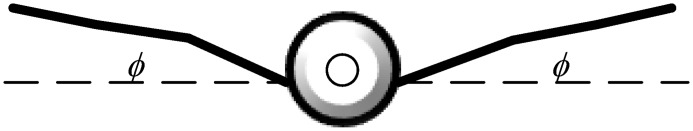
Auxiliary diagram of the flapping motion with the definition of the flapping angle.View in the direction of the flow.